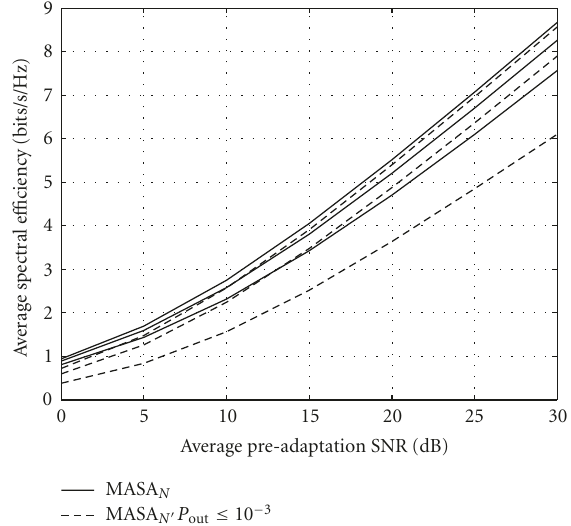
Figure 8: MASA N as a function of γ , with a constraint on the prob- ability of no transmission (solid lines) and without (dashed lines). Plotted for N = 2 (lowermost curve for both series), 4, and 8 (up- permost curve for both series) [15] ( c (cid:2) 2006